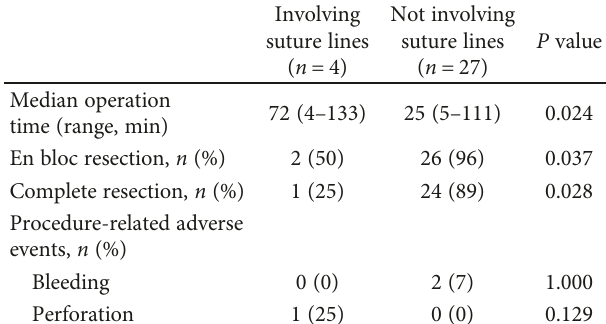
Table 4: Therapeutic outcomes of endoscopic submucosal dissection for gastric epithelial neoplasms in the remnant stomach, according to the involvement of the suture lines.